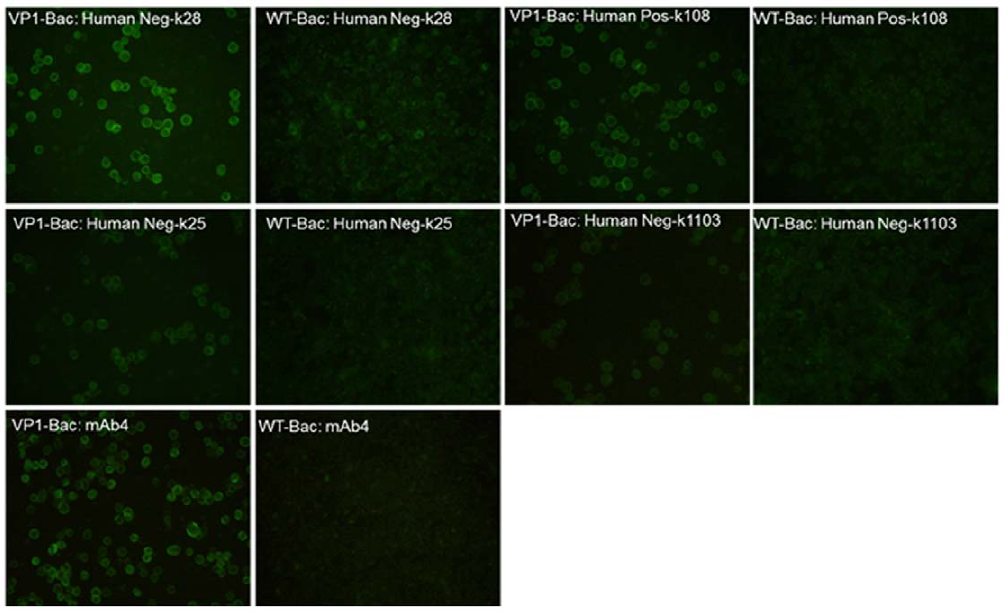
Figure 5. Detection of anti-VP1 antibody in human sera with baculovirus infected SF9 cells. SF9 cells were infected with either recombinant baculovirus expressing VP1 of EV71 (VP1-Bac) or baculovirus wild type (WT-Bac). Cells were fixed 36 h post infection and stained with different serum samples and secondary FITC antibody. Mab 4 is a VP1 specific monoclonal antibody that was used as a positive control. Human Neg: human serum sample which is negative in virus neutralization. Human Pos: human serum sample which is positive in virus